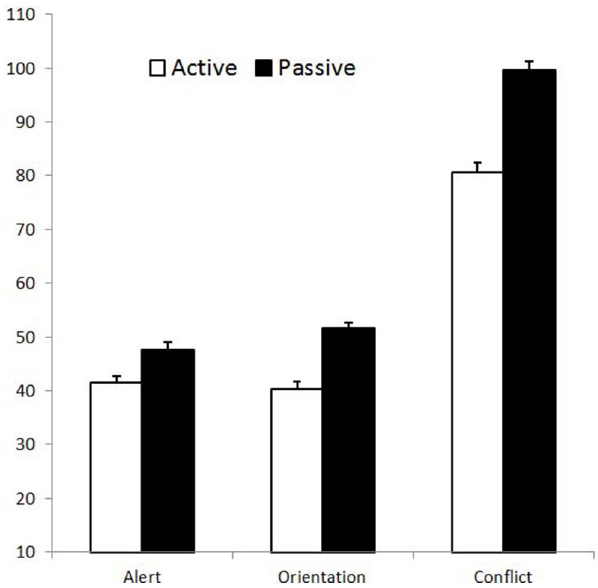
Figure 3. Orienting . Mean RTs in the central and spatial conditions associated to the orienting network, for active and passive participants. The error bars represent one standard error of the mean.